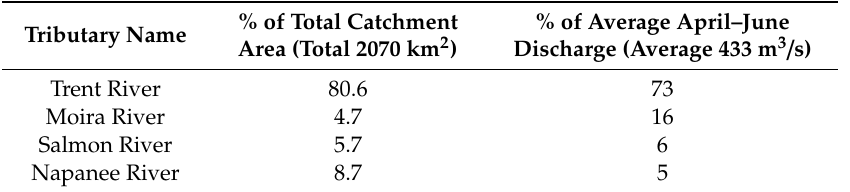
Table 1. Percent of total catchment area and average river discharge for Bay of Quinte tributaries. Total ECCC estimated discharges for April–June averaged over 2016–2019 (Trent River estimates derived following method discussed in Section